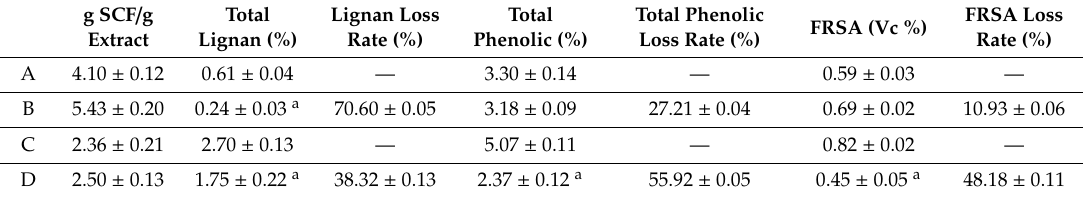
Figure 2. Determination of the total and individual lignan contents in samples A, B, C, and D. Note: The different letters above columns represent the significance of each index ( p < 0.05) among different samples. Table 2. Levels of total phenolic compounds (TP), free radical scavenging activity (FRSA), total lignans (TL) and organic acids (OA) in the samples A, B, C, and D and the corresponding levels in the crude material